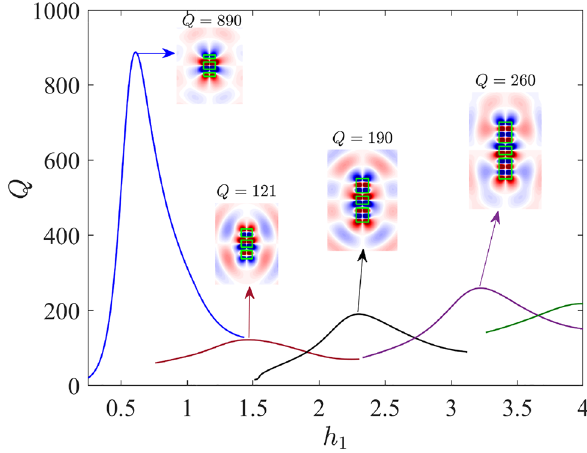
Figure 2: The Q -factors and corresponding resonant modes versus the thickness of disks of dimer. Other parameters are fixed: h = 1 . 244 , L = 0 . 592.